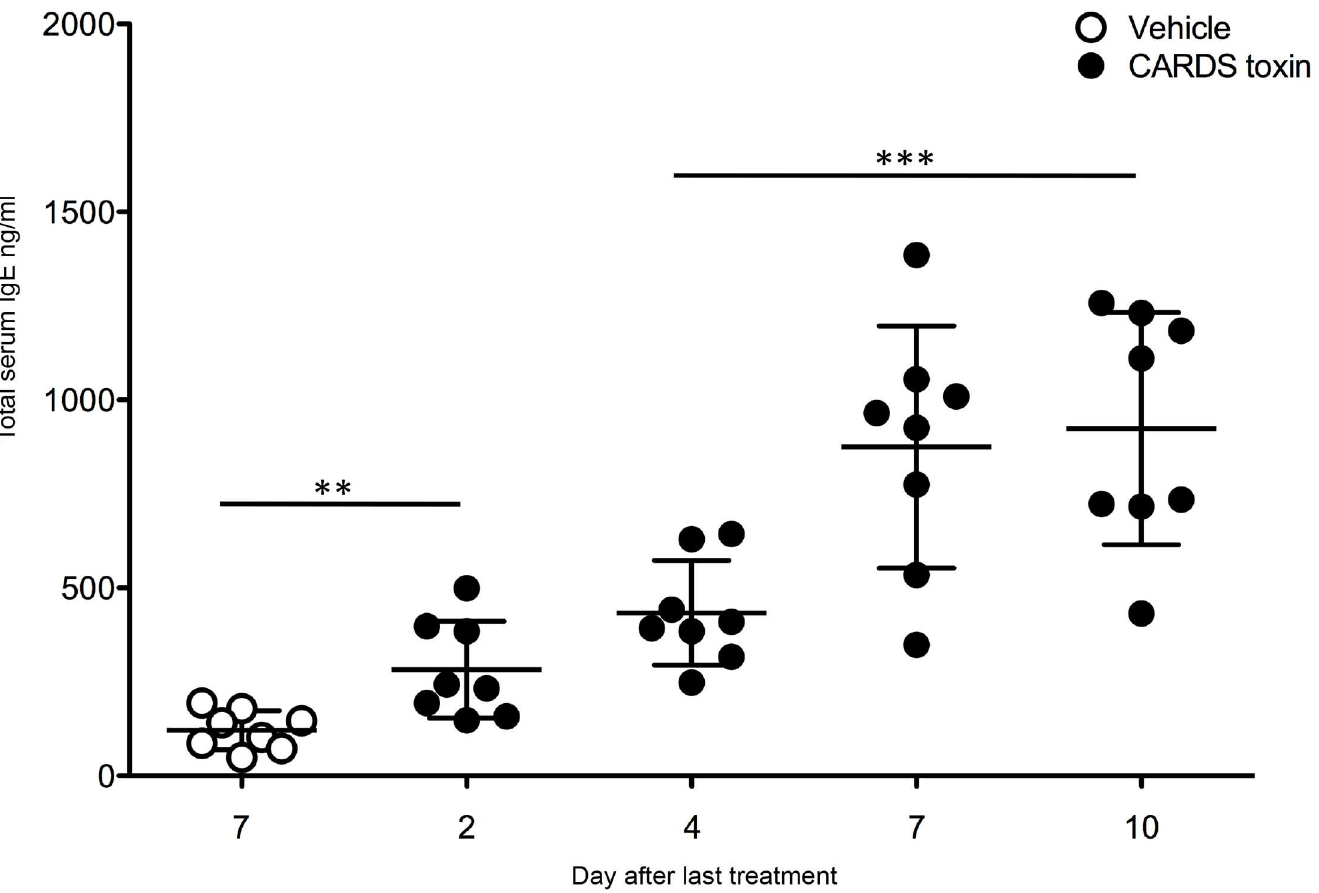
Fig 3. Multiple doses of CARDS toxin increasetotal serum IgE concentrations. Balb/cJ mice were treated IT with CARDS toxin or vehicleon day 0 and day 21. Mice were then bled on days 2, 4, 7, and 10 followingthe second exposure, and concentrations of total serum IgE measured. Total serum IgE from mice treated twice with vehicle were measuredon day 7 after the second treatment. Data representsthe mean and standard deviationof two independent experiments ( ** p < 0.005, *** p < 0.0005, N = 8 mice).